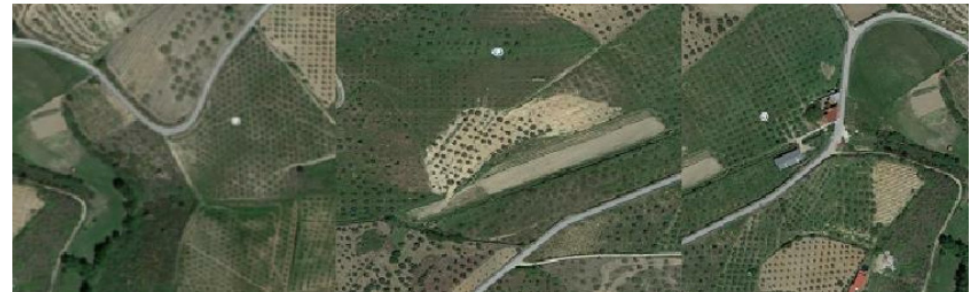
Figure 1. Photos of the harvesting local (aerial view obtained from Google maps according to the respective coordinates). Cultivar (from left to right): Madural, Verdeal, and Cobrançosa.